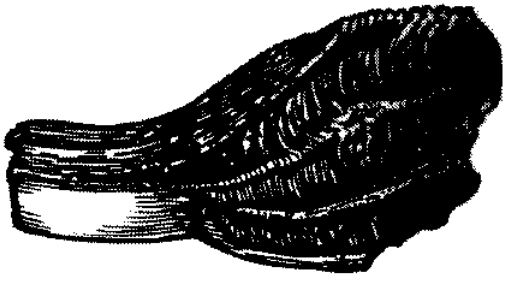
Fig. 2 – One of the fossil teeth of Iguanodon from the Wealden strata (Early Cretaceous) of England that were studied by Gideon Mantell (after Sarjeant 1997).